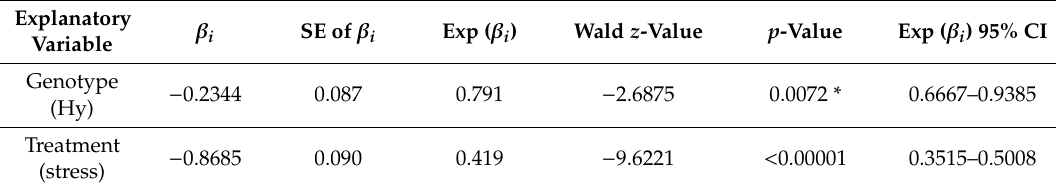
Table 2. Summary table of the Cox’s PH model for germination data. The z- value of the Wald test tests the hypothesis that β i = 0 against the alternative β i (cid:44) 0. p -value represents the probability of obtaining a z -value larger in absolute value than the one obtained. The asterisk on p -values indicates a statistical significance ( α <